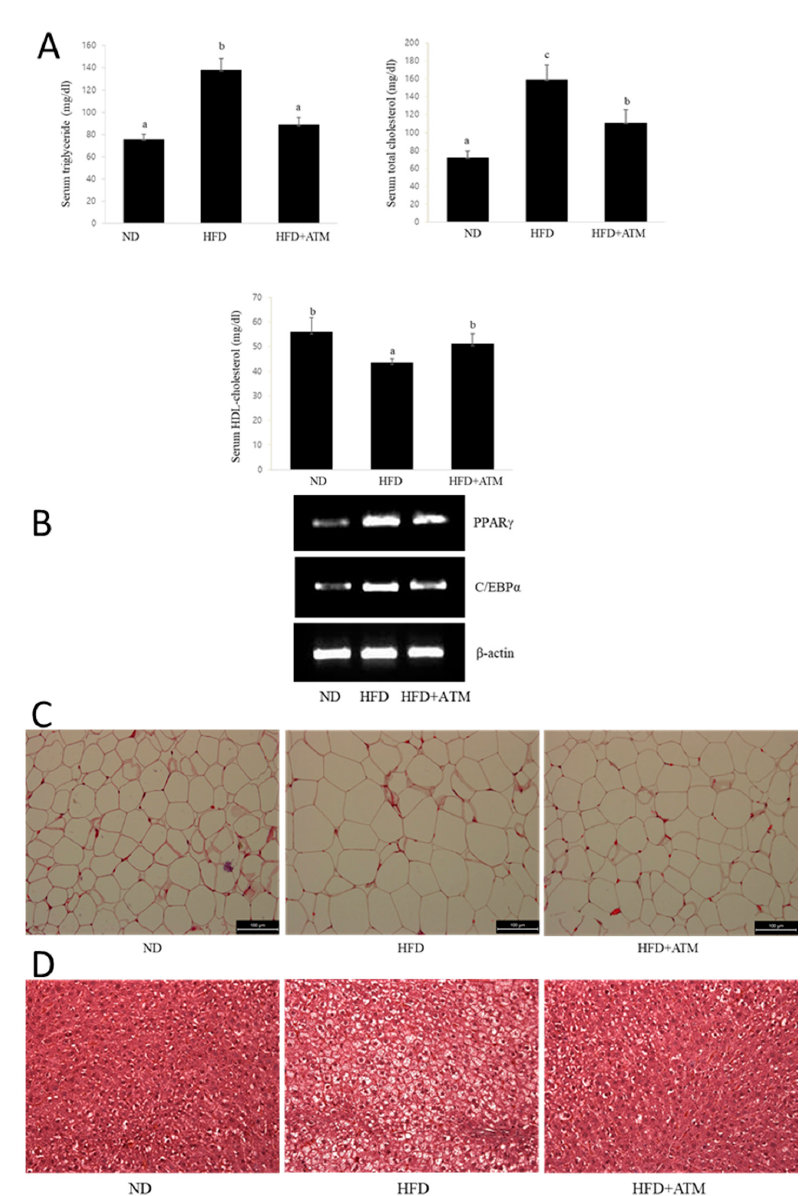
Figure 5. Lipid profiles and histological examination in rats fed with the HFD alone or HFD plus ATM. ( A ) E ff ects of ATM treatment on lipid content in HFD-induced obese rats. Significant decreases were observed in serum TG and total cholesterol (TC) levels of the ATM-treated group compared to the HFD alone group. High-density lipoprotein (HDL)-cholesterol (HDL-C) levels were significantly higher in the ATM-treated group compared to that in the HFD alone group. Values are presented as the means ± SD. Bars with di ff erent letters are significantly di ff erent ( p < 0.05). ( B ) E ff ects of ATM on mRNA expression in epididymal adipose tissues. ATM administration depressed the expression of C / EBP α and PPAR γ in the epididymal adipose tissue of HFD-induced obese rats. ( C ) E ff ects of ATM on histology of epididymal adipose tissue of rats fed an HFD. Histological analysis of epididymal adipose tissue after staining with hematoxylin and eosin (H&E) followed by microscopic analysis. Scale bar is 100 µ m. ( D ) E ff ects of ATM on lipid accumulation in liver tissues. Histological analysis of liver after staining with H&E followed by microscopic